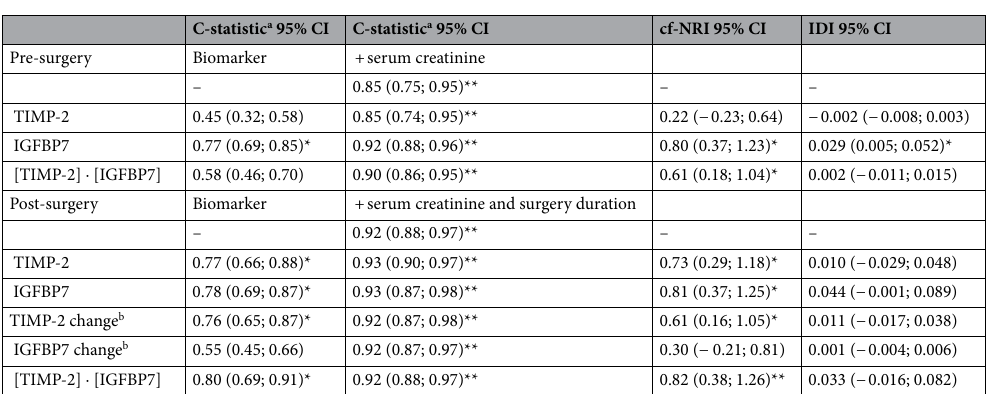
Table 2. Discrimination and reclassification performance with 95% CI of urinary biomarkers, change in biomarkers during surgery, and the biomarker product [TIMP-2] · [IGFBP7], regarding risk of renal replacement therapy. cf-NRI, category-free net reclassification improvement; CI, confidence interval; IDI, integrated discrimination improvement; IGFBP7, insulin-like growth factor-binding protein 7; TIMP-2, tissue inhibitor of metalloprotease-2. * p < 0.05, ** p < 0.001. a Analyses were weighted towards the distribution of long vs short intensive care unit (ICU) stay of the original cohort. b Change means the absolute difference between pre-surgery and post-surgery